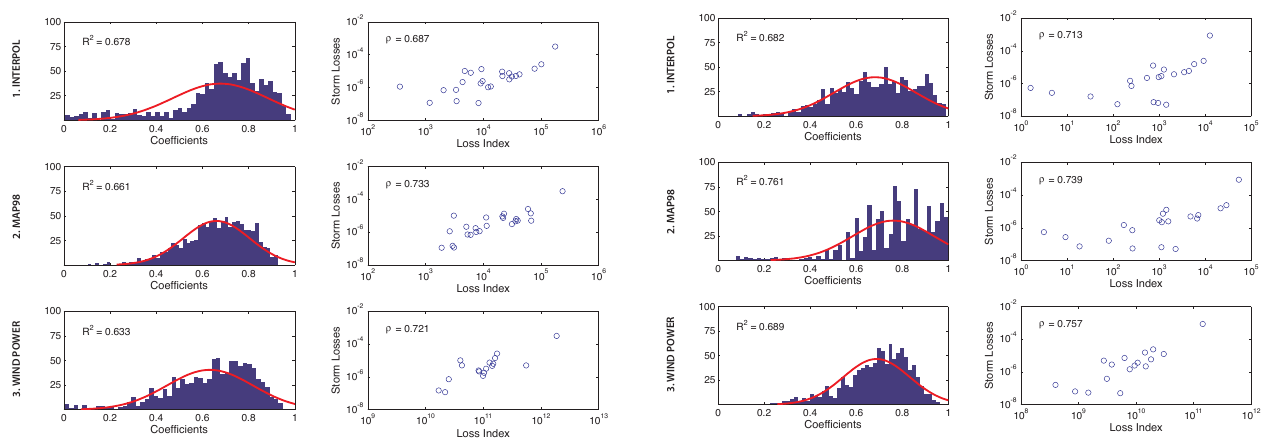
Fig. 3. Model results for the canton of Vaud plotted for the 3 meth- ods: INTERPOL (top), MAP98 (middle) and WIND POWER (bot- tom). Left: bootstrap results, with histograms of the determination coefficients values for the 1000 samples of the bootstrap. Mean val- ues are shown on the graphs. Right: scatter-graphs, with calculated loss indices on the abscissas and observations on the ordinates (loss ratios, expressed in CHF 0.01 per CHF 1000 insured). All scales are log scales. The Spearman’s rank correlation coefficients ( ρ) are shown.